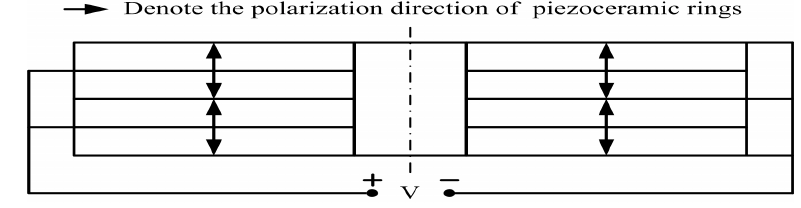
Figure 7. The piezoelectric ceramic stack composed of four same thickness-poled rings.